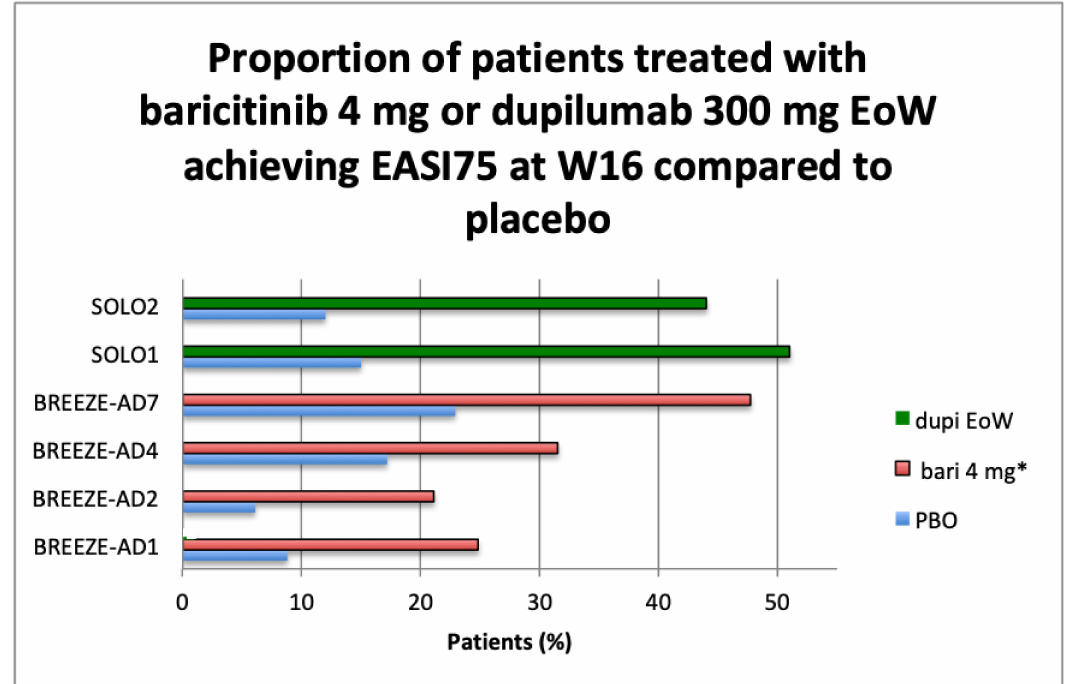
Figure 4. Overview of primary efficacy endpoint from RCTs: Proportion of patients treated with baricitinib 4 mg or dupilumab 300 mg EoW achieving EASI75 at W16 compared to placebo. Abbreviations: PBO, placebo; IGA, investigator global assessment; W16, week 16; EoW, every other week; dupi, dupilumab; bari, baricitinib. * In BREEZE-AD 4 and AD7, baricitinib was administered in association with topical corticosteroid as for